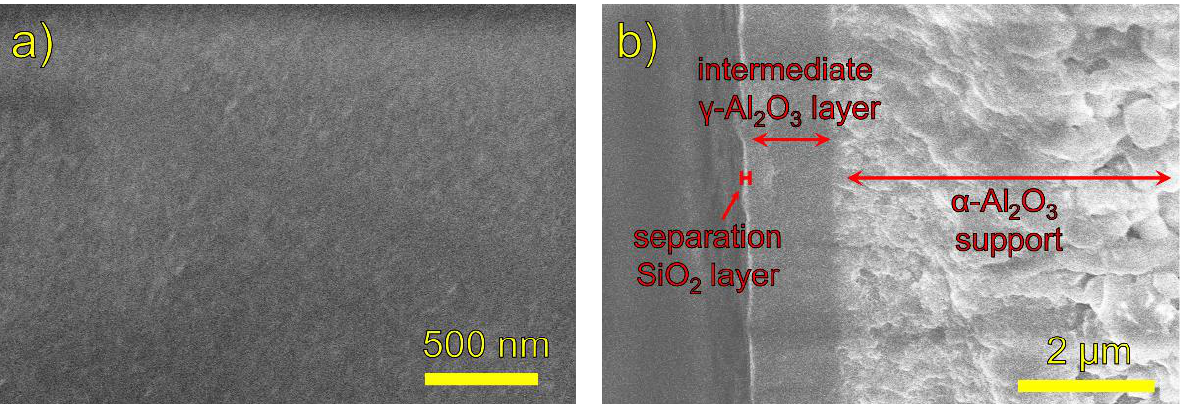
Figure 2. SEM micrographs of membrane Si-10Ta-650: ( a ) surface image; ( b ) cross-sectional image.